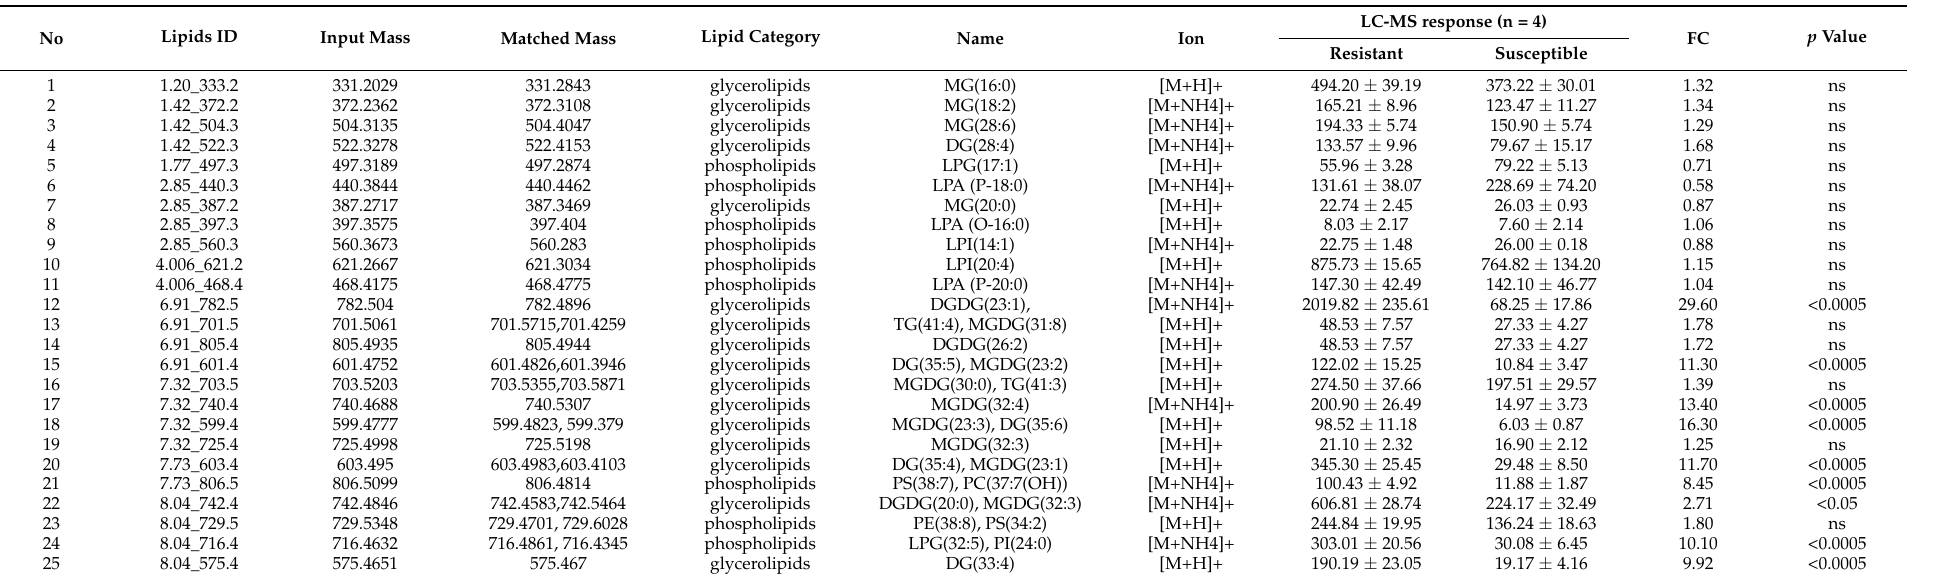
Table 2. Glycerolipids and phospholipids candidates obtained from R. dominica